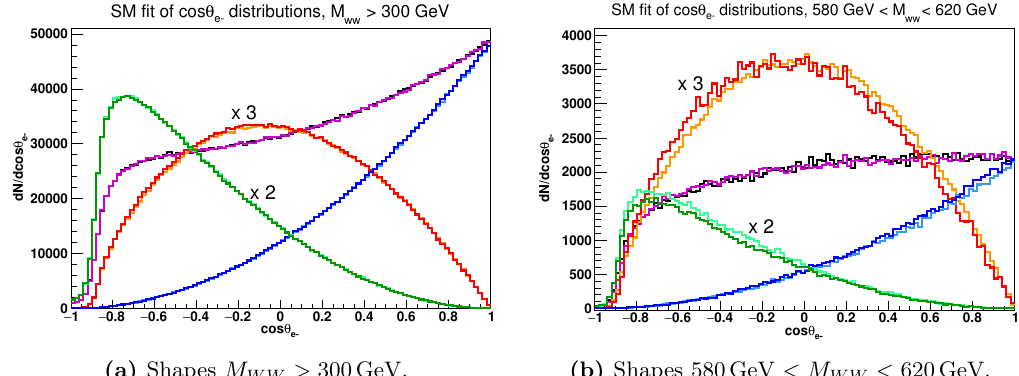
Figure 10. Shape comparison between SM and Singlet generation. Lines as in (cid:12)gure